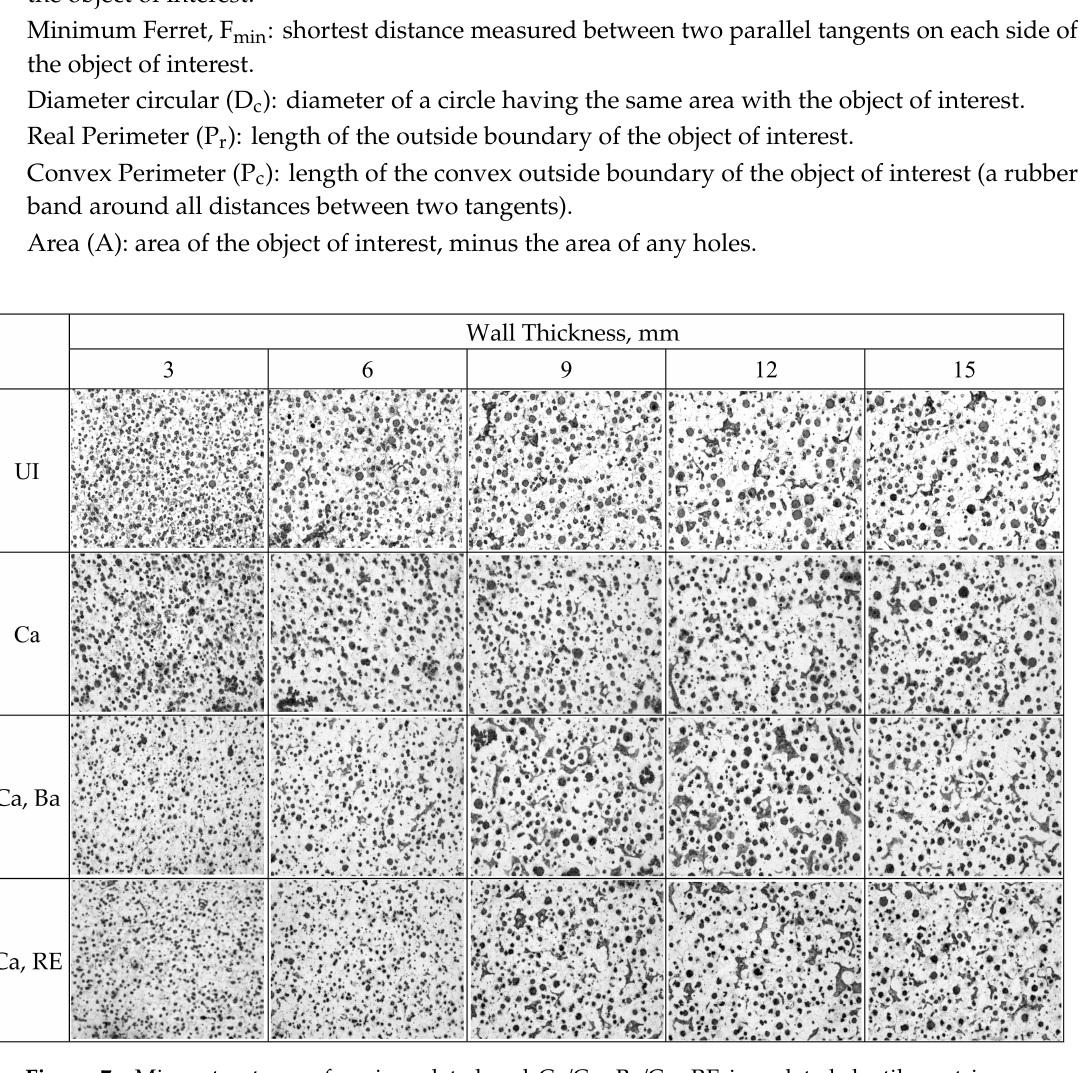
Figure 7. Micro-structures of un-inoculated and Ca / Ca, Ba / Ca, RE inoculated ductile cast irons, at di ff erent wall thickness (W 3 wedge casting, ASTM A 367) (Nital 2%